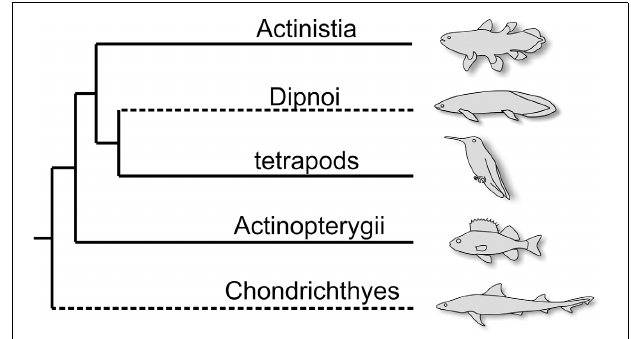
FIGURE 1 | Interrelationships among the five crown-vertebrate clades. The lineages with stippled lines are not included in this study, because their fossil record is mostly composed of fragmentary remains (teeth and tooth plates) for the second half of their evolutionary